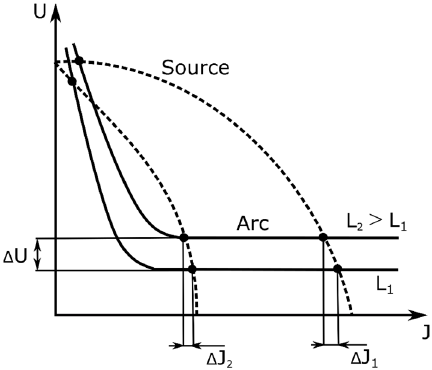
Figure 3. Changes in parameters in the case of welding with average current densities. Welding arcs glow brightly, and that glow comes from the radiation that the arc produces. Part of the radiation is visible light, in the 400 to 700 nm range, while the other part of the radiation is infrared (700 to 1400 nm) and is the part that produces heat. There is also some UV radiation in the range of 200 to 400 nm.